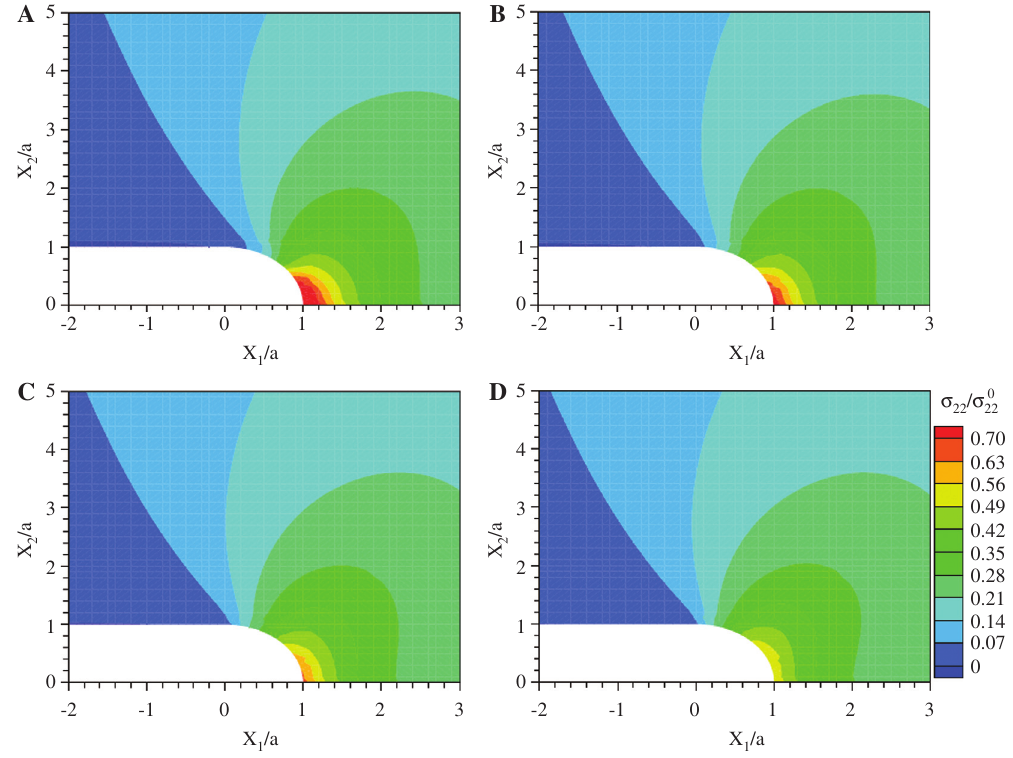
Figure 6 The influence of surface energy and crack root bluntness on the stress distribution near the crack tip [124].